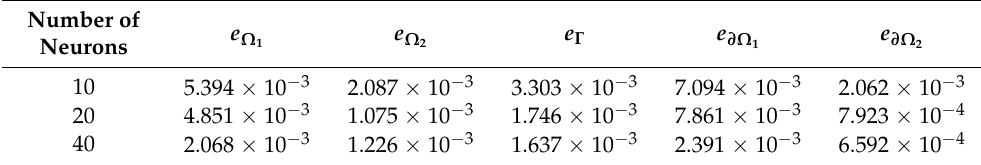
Table 12. Comparison of errors in different terms with different numbers of neurons for Example 6. Number